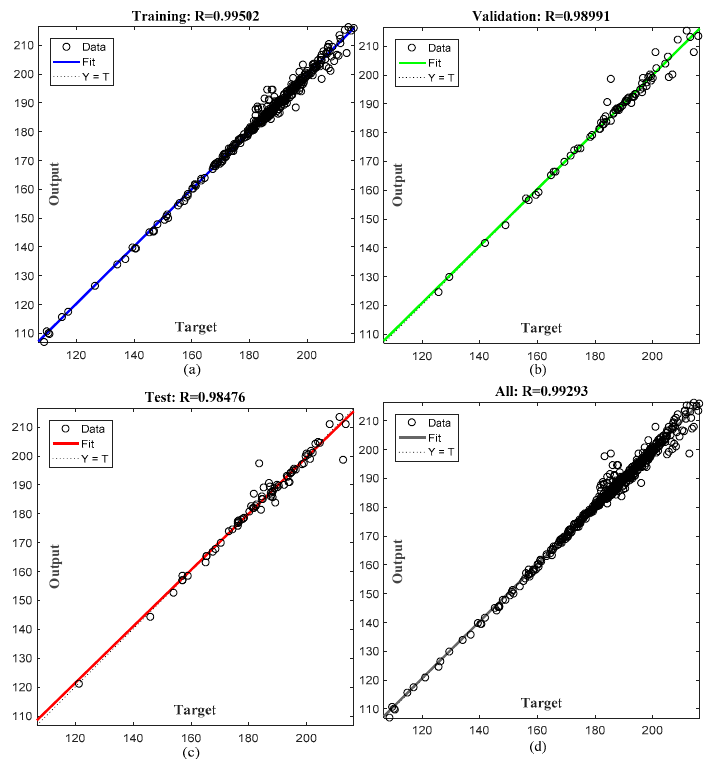
Figure 4. NARX training performance for: ( a ) training dataset; ( b ) validation dataset; ( c ) test dataset; and ( d ) overall dataset.